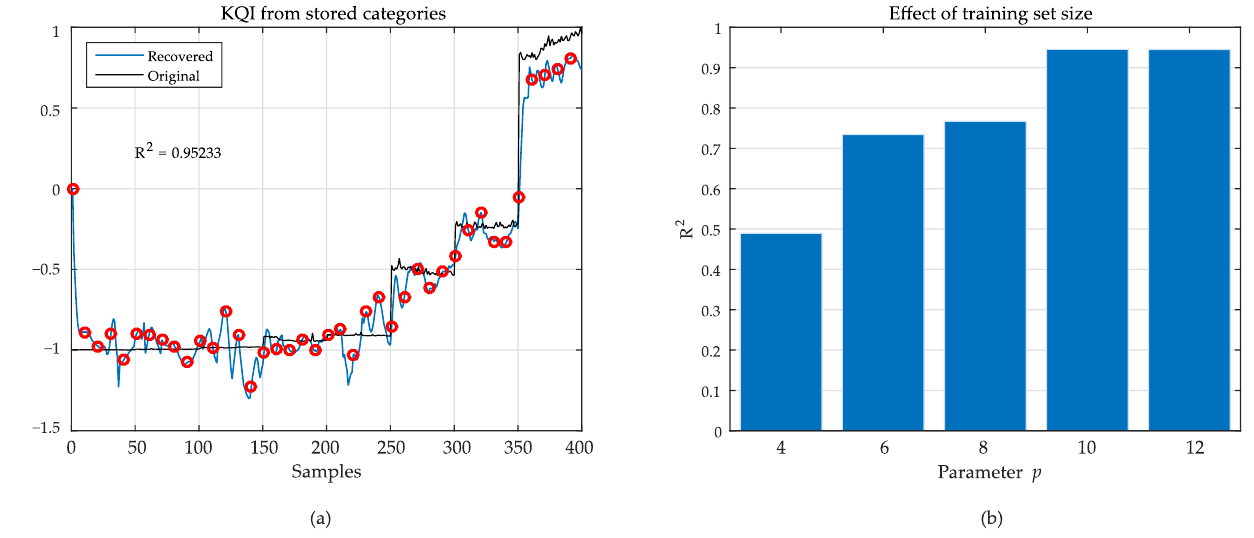
oper at left (a). Black: original data; blue: recovered KQI. Red dots are samples used for oper at left ( a ). Black: original data; blue: recovered KQI. Red dots are samples used for Figure 9. Recovered KQI from w Figure 9. Recovered KQI from w P } P } { { testing, not present in the training data. At right (b), the effect of the size of the training set in R 2 . testing, not present in the training data. At right ( b ), the effect of the size of the training set in R 2 .